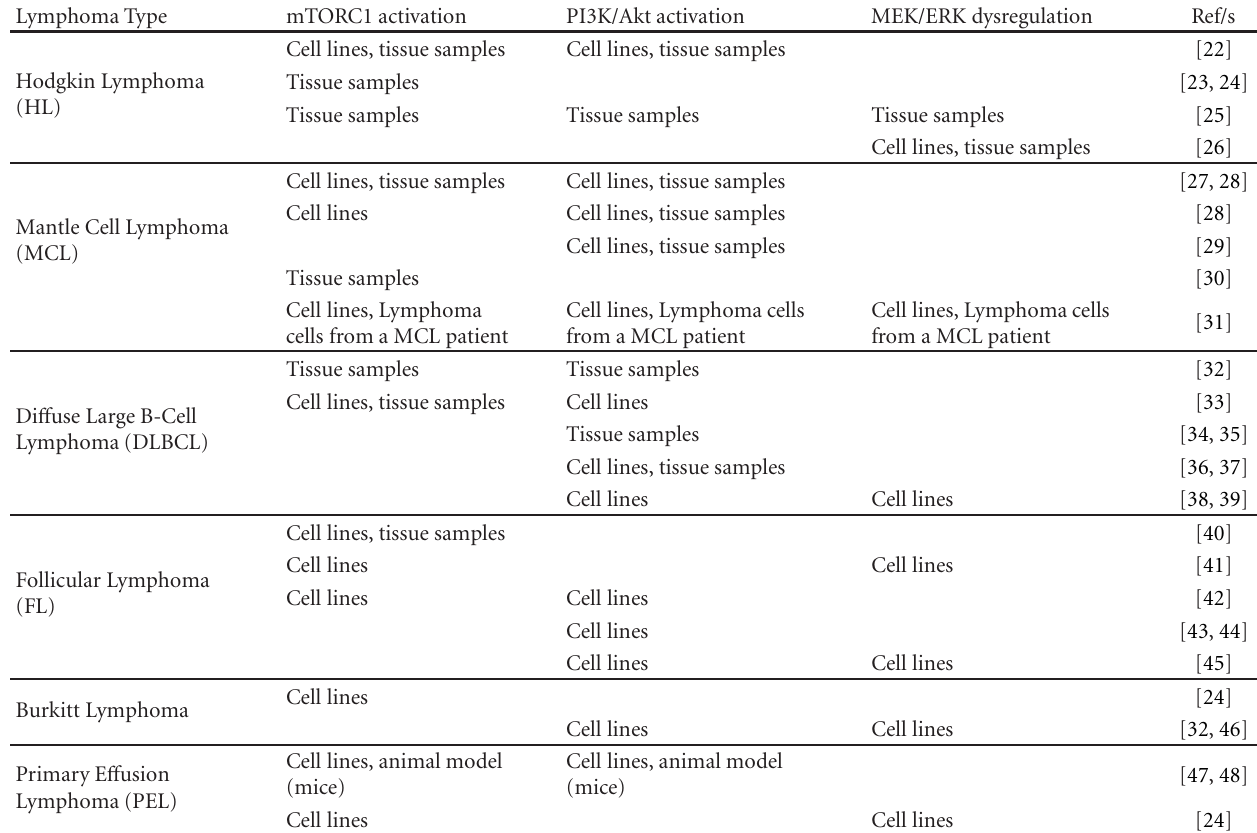
Table 1: Evidence of aberrant activation of mTORC1, PI3K/Akt, and Raf/MEK/ERK pathways in B-cell